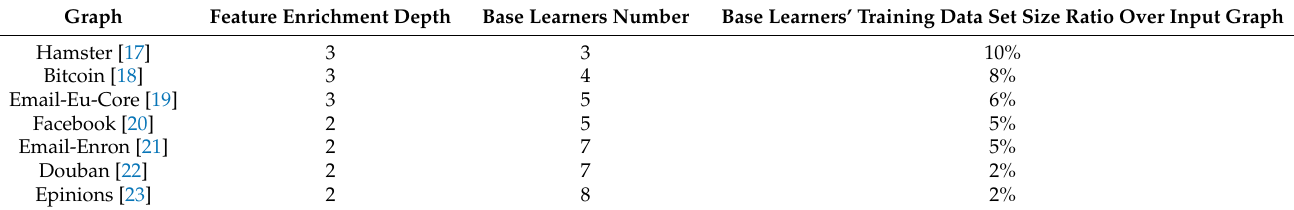
Table 3. Distributed bagging ensemble [16] community prediction methodology execution parameters per distinct so- cial